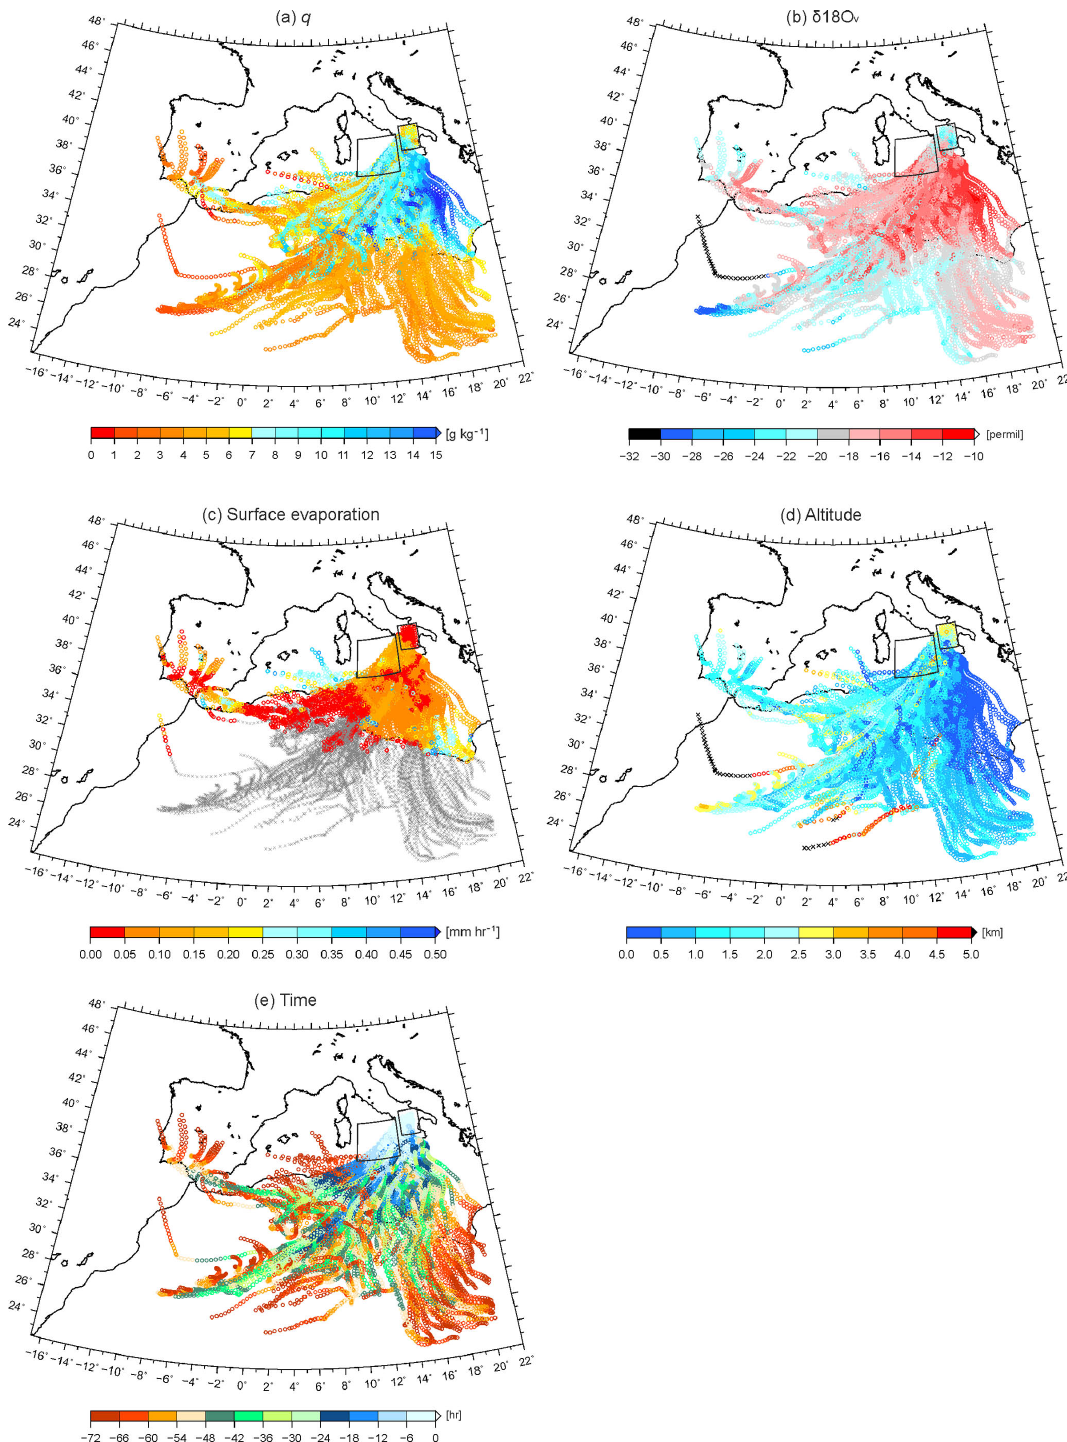
Figure 11. Same as Fig. 7 but for the air parcel arriving at SI in the 800–700hPa layer at 00:00UTC on 16 October